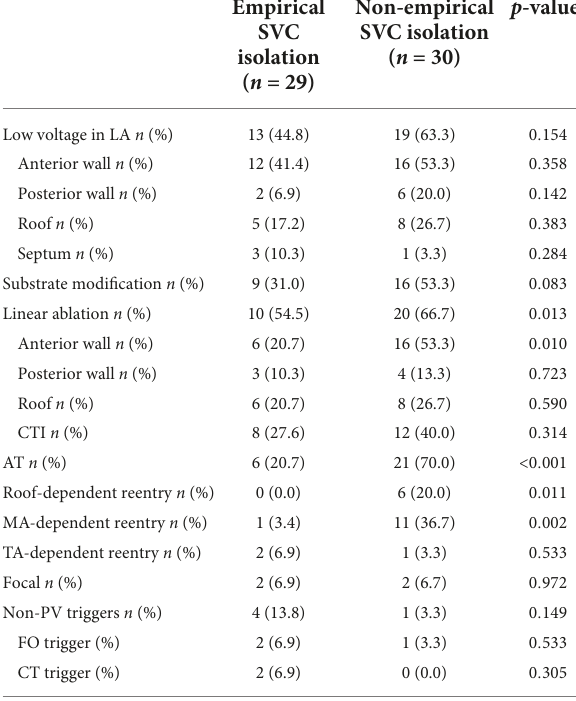
TABLE 4 Procedural characteristics of empirical and non-empirical superior vena cava (SVC) isolation groups.